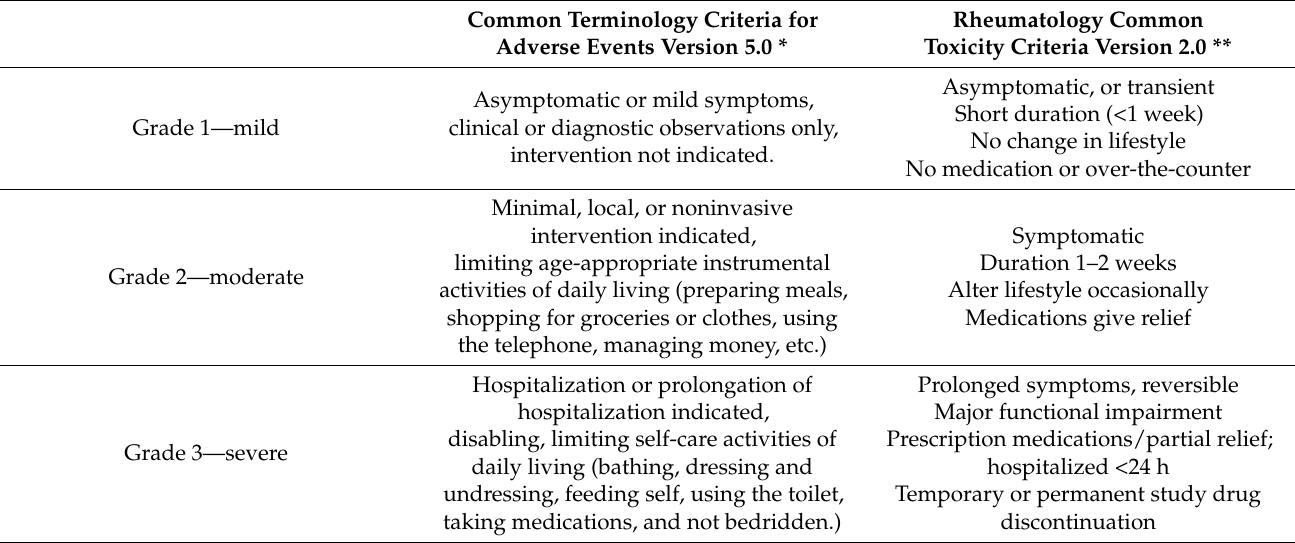
Table 1. Comparison of ‘oncological’ Common Terminology Criteria for Adverse Events and Rheuma- tology Common Toxicity